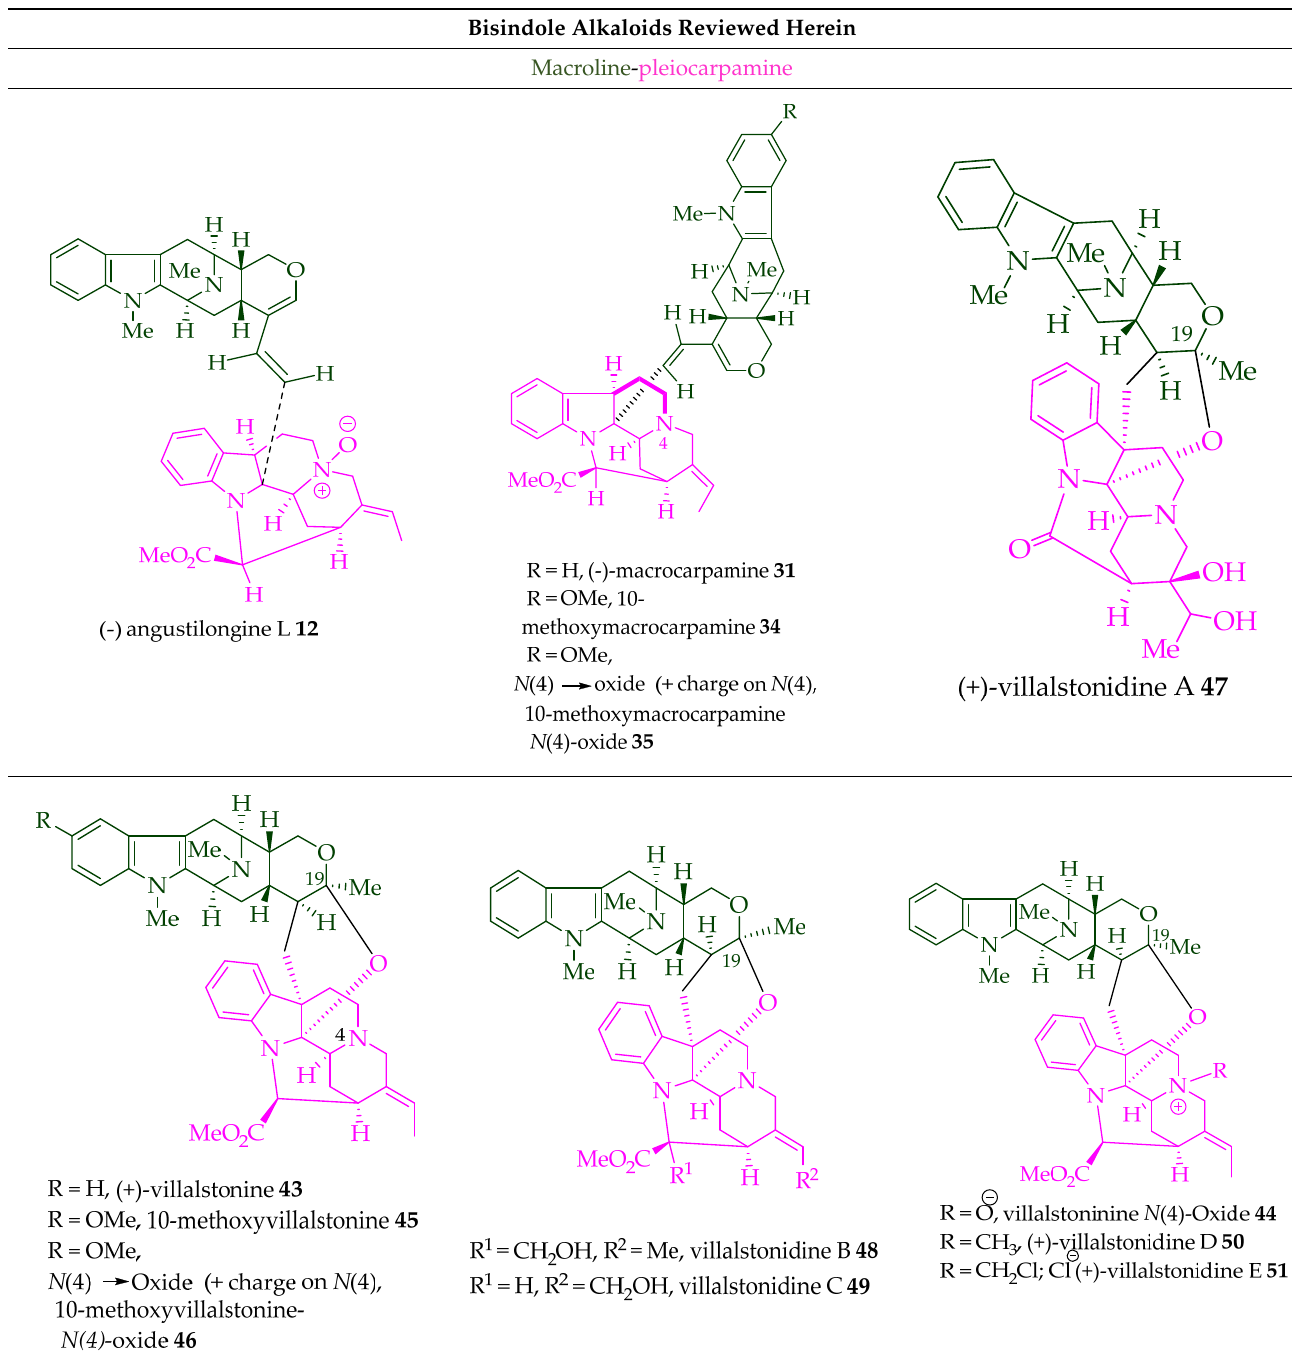
Table 2. Cont . Bisindole Alkaloids Reviewed Herein